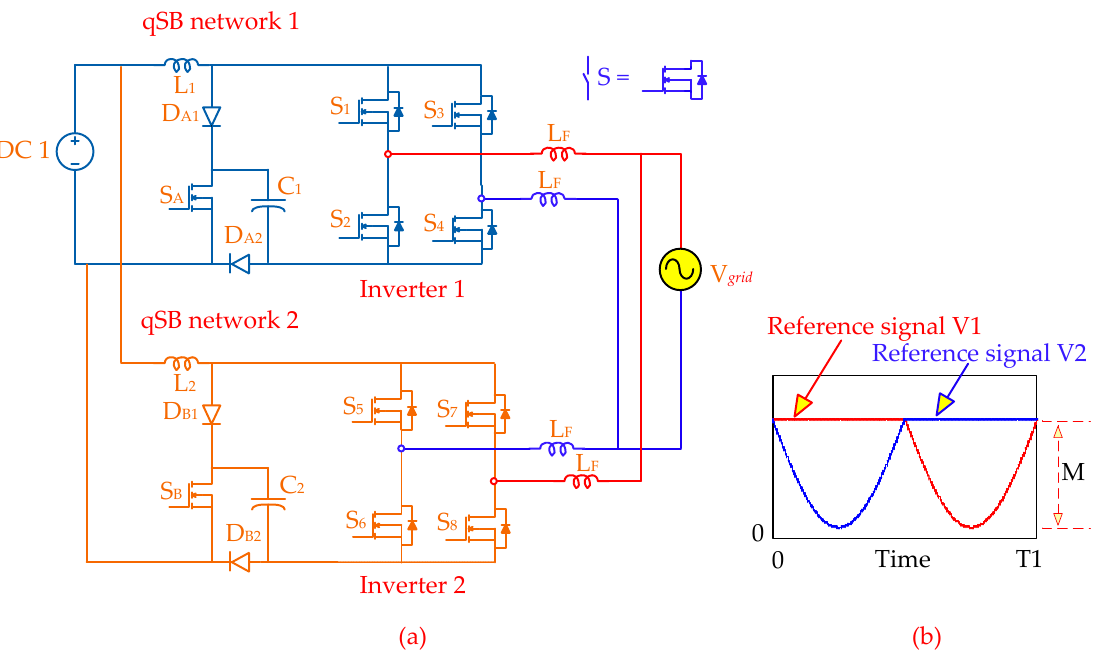
Figure 24. ( a ) Interleaved quasi-switched boost inverter topology; ( b ) Reference signal waveform.